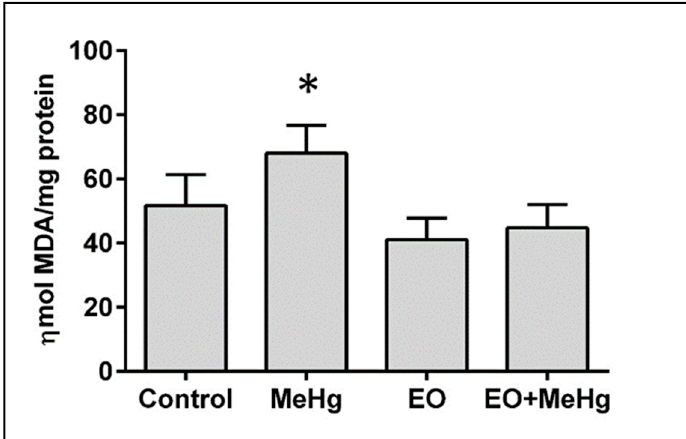
Figure 5. Euterpe oleracea consumption prevents lipid peroxidation in brain caused by methylmercury. Mice were treated with clarified E. oleracea juice (EO) once a day for 8 days and / or methylmercury (MeHg) for 4 days. Data are presented as mean ± SEM ( n = 6–8). * p < 0.05 vs all groups.